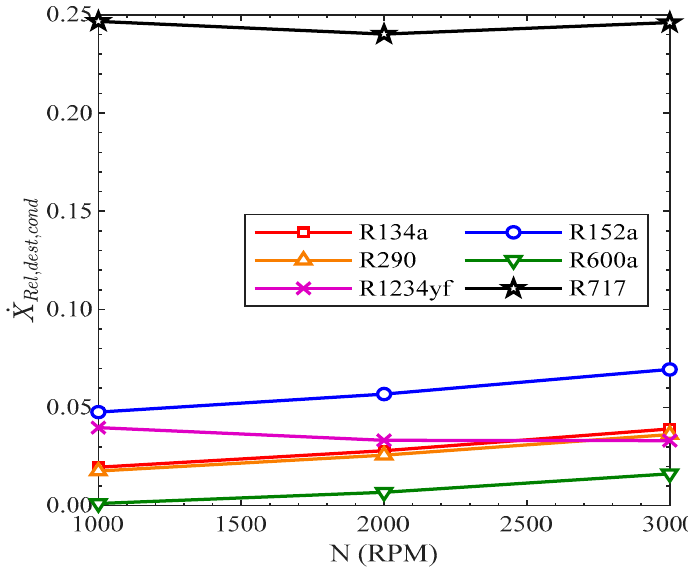
Figure 14 . Relative exergy destruction of condenser vs. compressor speed .